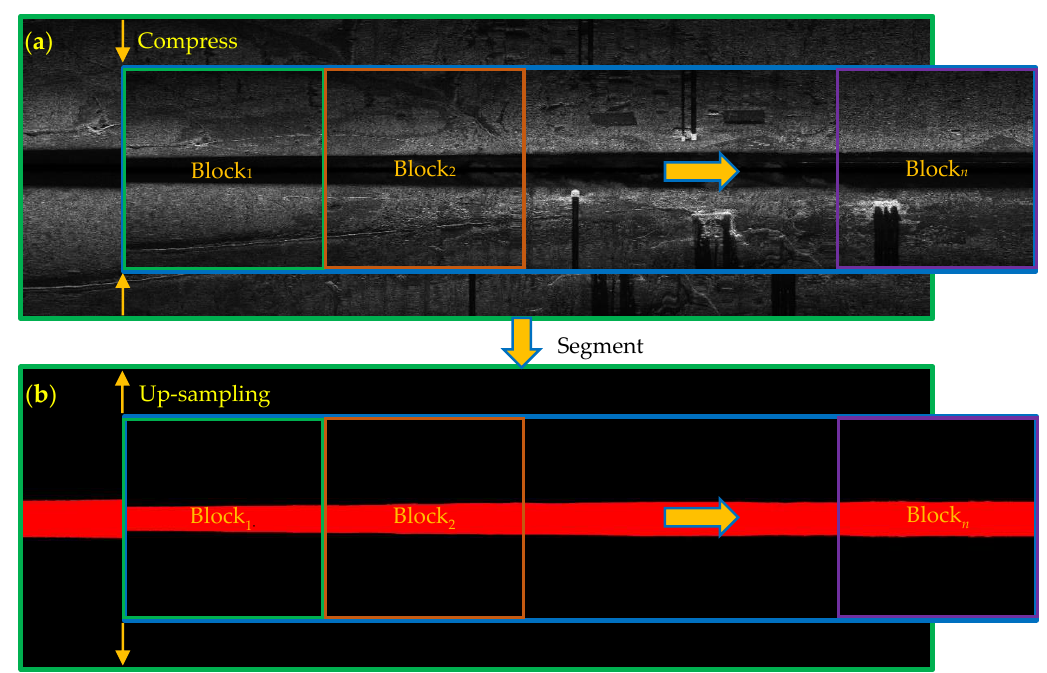
Figure 6. The segmentation process of high-resolution side-scan sonar waterfall image. ( a ) Raw waterfall image. ( b ) Seg- mentation map.